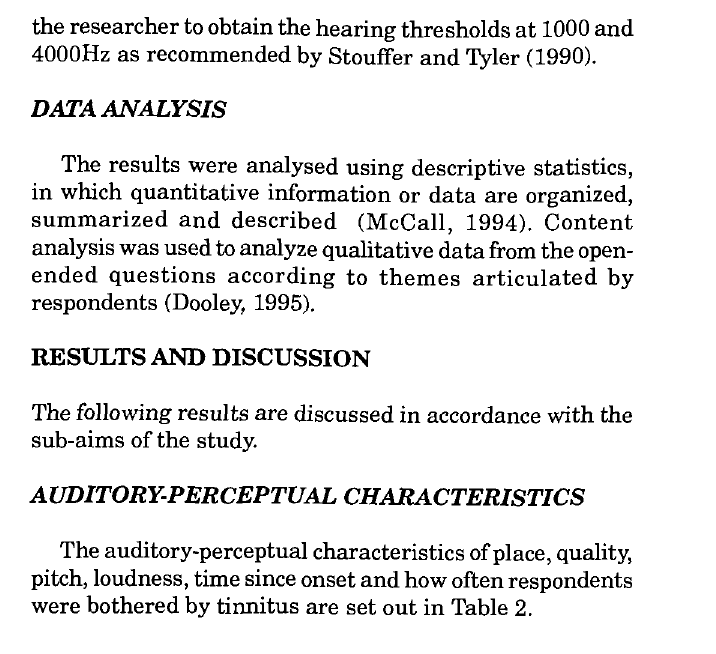
TABLE 2: Description of auditory-perceptual characteristics of tinnitus (N=20) Tinni tus